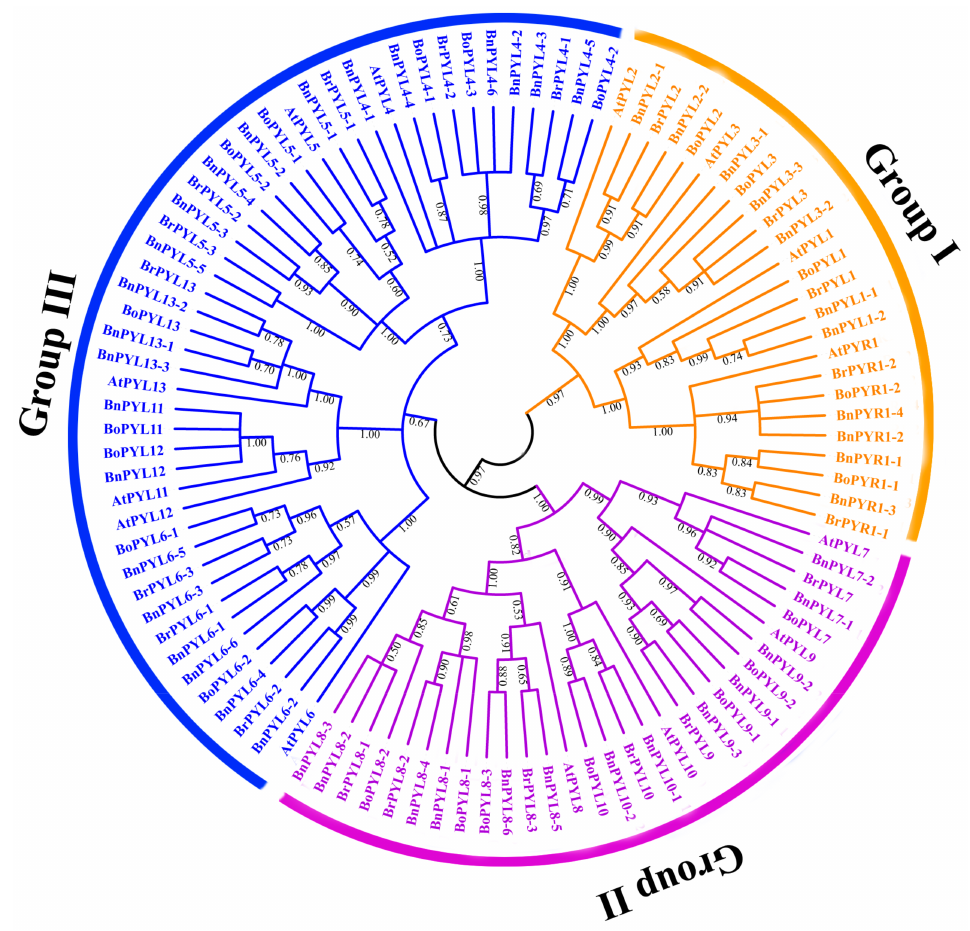
Figure 2. Phylogenetic tree analysis of PYLs in Arabidopsis thaliana , B. napus , Brassica rapa and Brassica oleracea . In total, 14 AtPYLs from A. thaliana , 24 BrPYLs from B. rapa , 23 BoPYLs from B. oleracea and 46 BnPYLs from B. napus were included. These 107 sequences were used to construct a neighbor-joining (NJ) tree. The tree was divided into three groups, represented by different